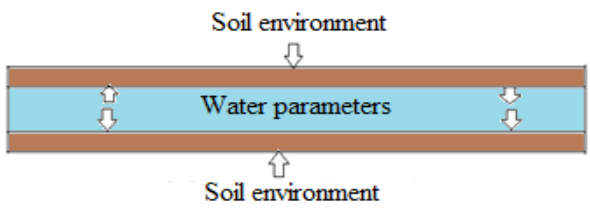
Figure 1. Schematic of the buried water pipe and its environments.